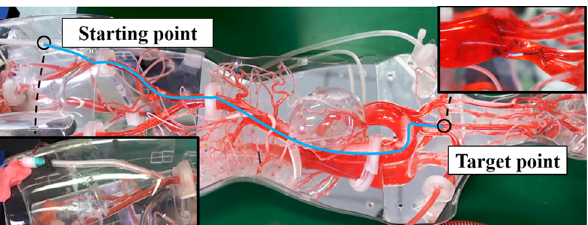
Figure 12. Experiment setup of the vascular model. Including the starting position (the femoral artery) and the target position (the left subclavian aorta).